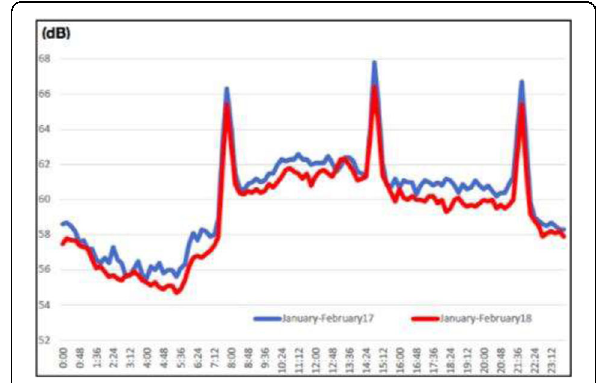
Fig. 1 (abstract 0347). Relationship between noise level and time in the same period of 2017 and